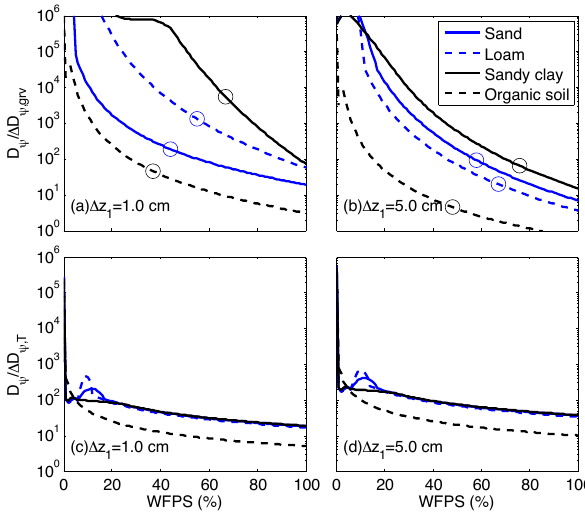
Figure 9. Impact of the gravity (a, b) and non-isothermal (c, d) corrections on computing the effective soil diffusivity for the four soils listed in Table 3. The circles in panel (a) and (b) indicate the threshold soil moisture where the soil evaporation efficiency equals to 0.90. The ratios are represented in absolute magnitude. The wiggles and discontinuities in the figure resulted from using the Silva and Grifoll (2007) approach to obtain the full range soil water retention curves (see the text for details).